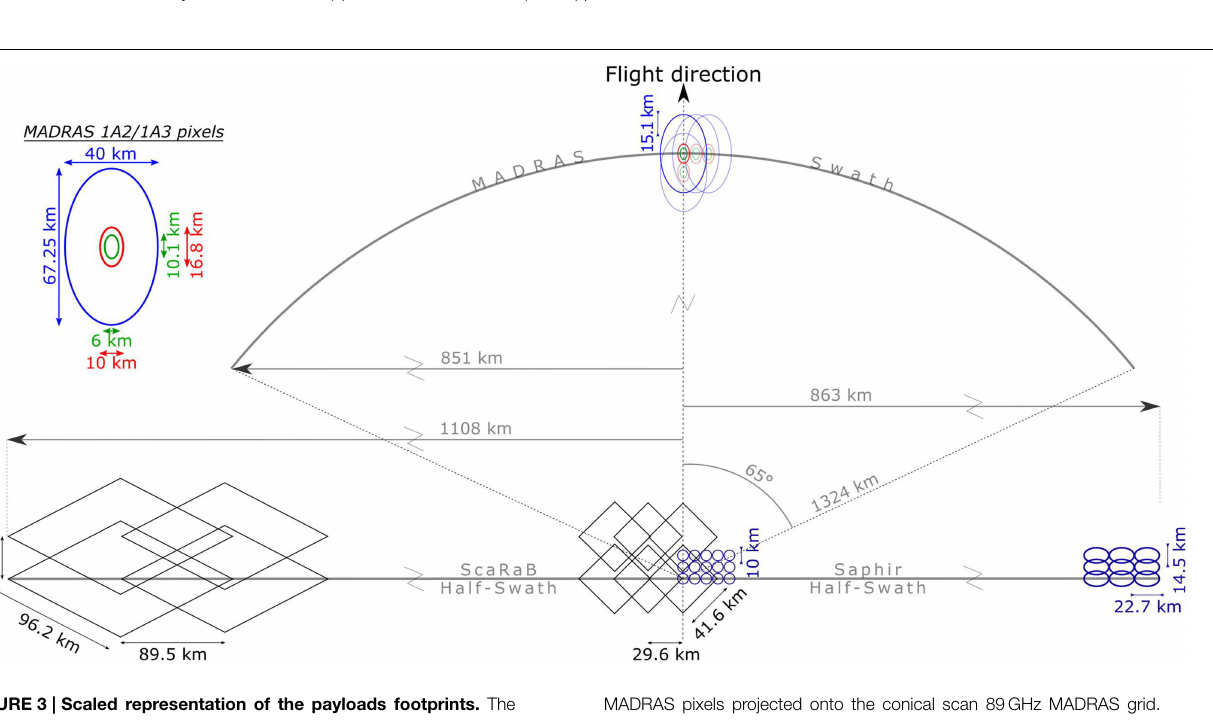
MADRAS pixels projected onto the conical scan 89GHz MADRAS grid. Data are interpolated from L1A for SCARAB and L1A2 for SAPHIR inside a fixed grid related to the current orbit and defined by the location of MADRAS 89 GHz pixels centers. Note that the level 1A2 and 1A3 products are identical for